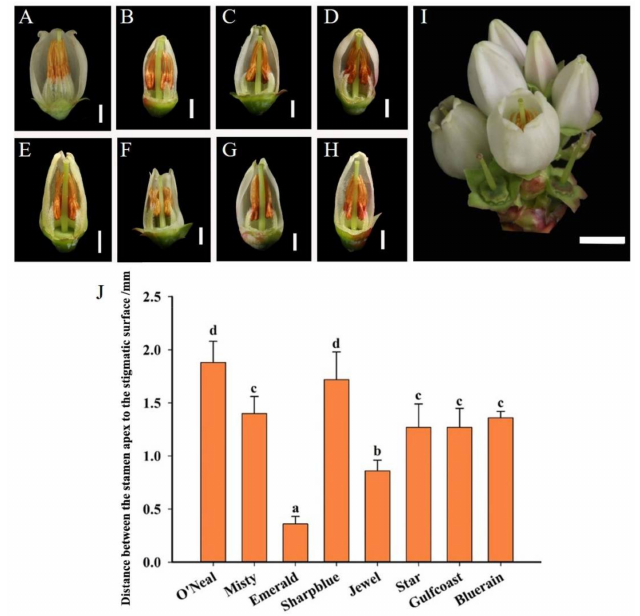
Figure 1. Floral diversity of eight southern highbush blueberry cultivars. ( A ) ‘O’Neal’; ( B ) ‘Misty’; ( C ) ‘Emerald’; ( D ) ‘Sharpblue’; ( E ) ‘Jewel’; ( F ) ‘Star’; ( G ) ‘Gulfcoast’; ( H ) ‘Bluerain’; and ( I ) Flowers of blueberry. Bar: A to H = 2 mm; I = 0.5 cm. ( J ) The distance between the stamen apex to the stigmatic surface. The X axis indicates different blueberry cultivars. Bars with different letter superscripts are significantly different from each other at the p < 0.05 level using Duncan’s test.